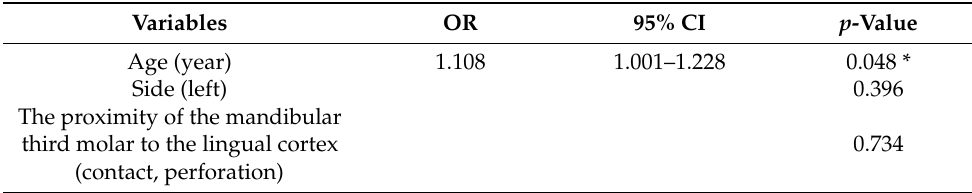
Table 4. Multivariate Logistic Regression of the Occurrence of Inferior Alveolar Nerve Injury versus Demographic and Procedural Variables in the Exposed